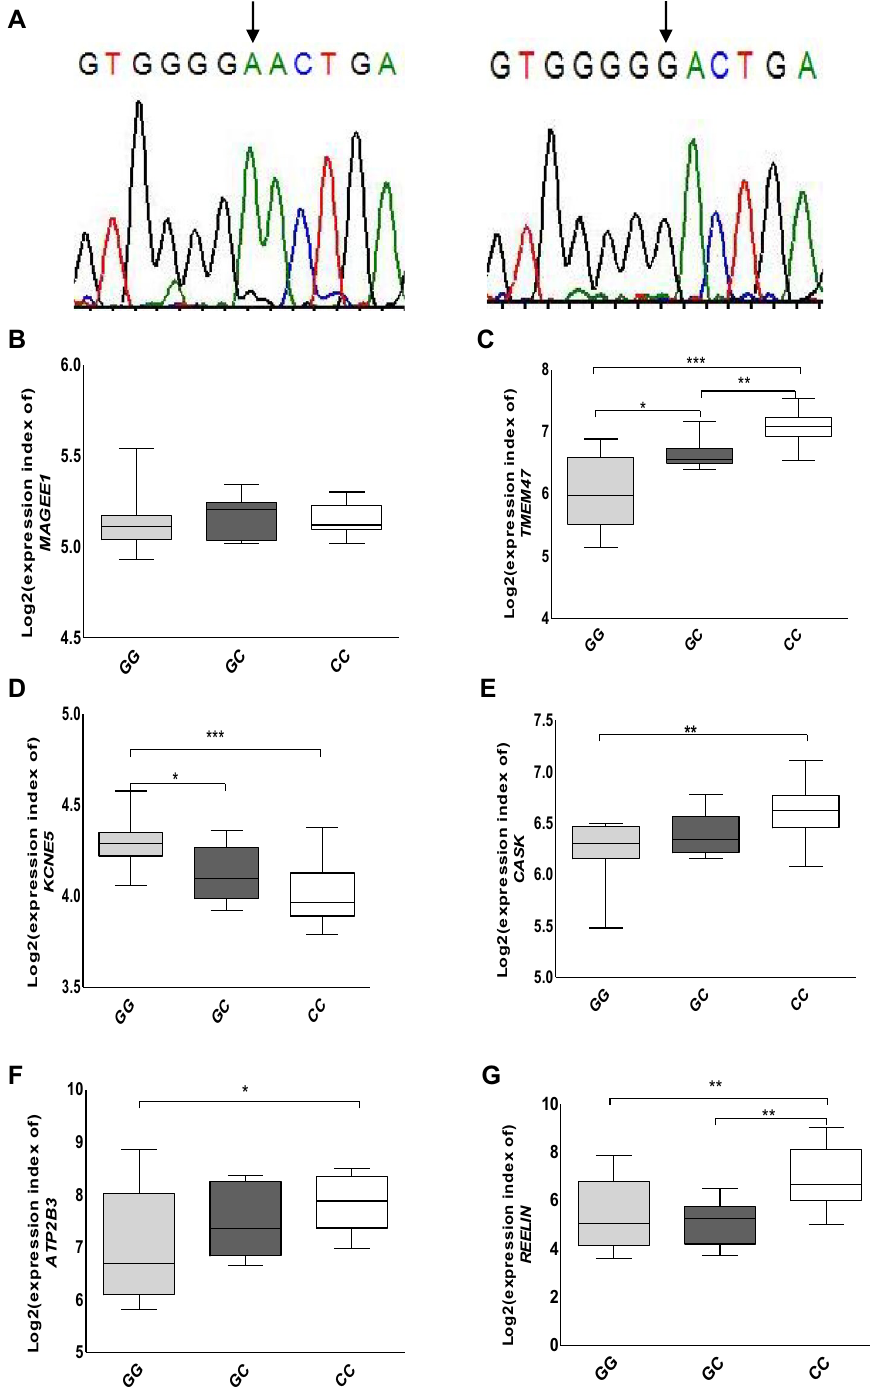
Figure 3. Sequencing of MAGEE1 and eQTL analysis. ( A ) The germline sequence variant identified in MAGEE1 (left) in comparison to the normal sequences from a non-mutated sample (right). ( B-G ) Log2 expression of MAGEE1 , TMEM47 , KCNE5 , CASK , ATP2B3, and REELIN after normalization of mRNA microarray data from patient tissue. * P < 0.05, ** P < 0.005, *** P < 0.0005, 2-tailed student